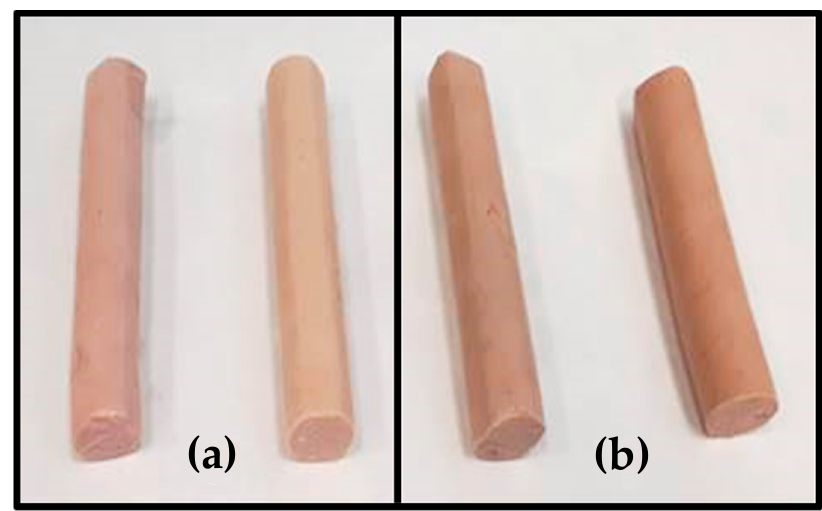
Figure 1. Example of healthy meat products with enhanced lipid content based on used structured lipids (as an animal fat replacer : (a) emulsion gels) and (b) oil bulking agent.